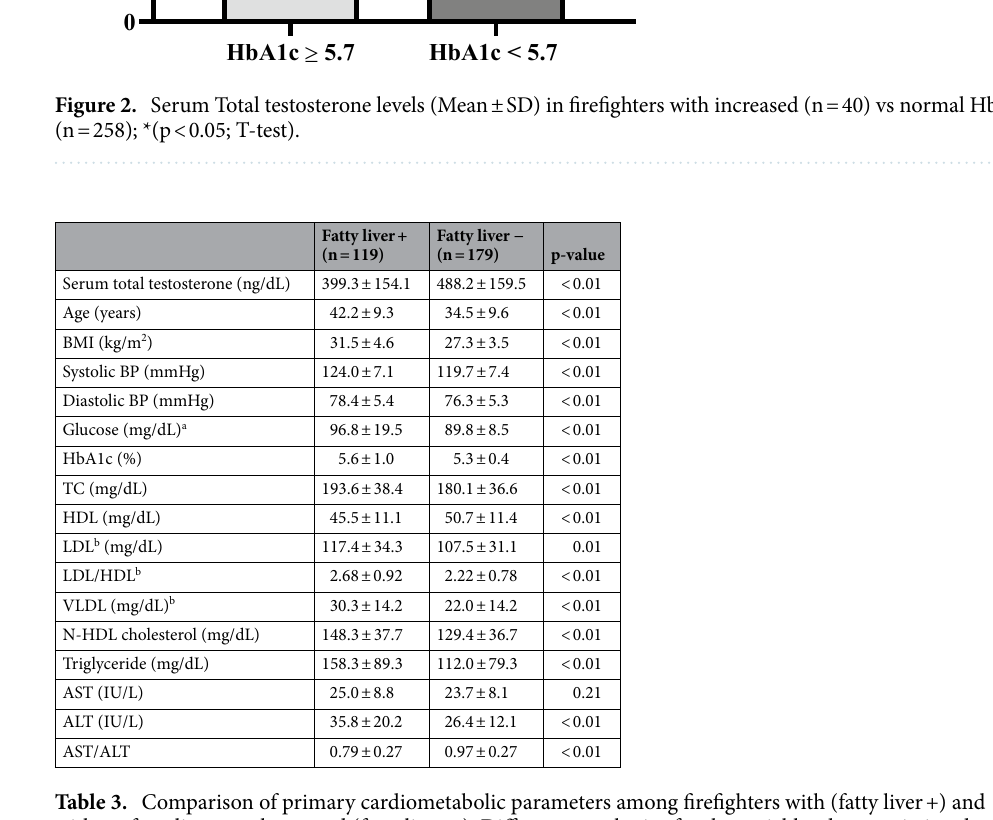
Table 3. Comparison of primary cardiometabolic parameters among firefighters with (fatty liver +) and without fatty liver on ultrasound (fatty liver −). Different sample size for the variables due to missing data: a Fatty liver+ (n = 116), Fatty liver− (n = 177); b fatty liver+ (n = 116), Fatty liver− (n = 178).